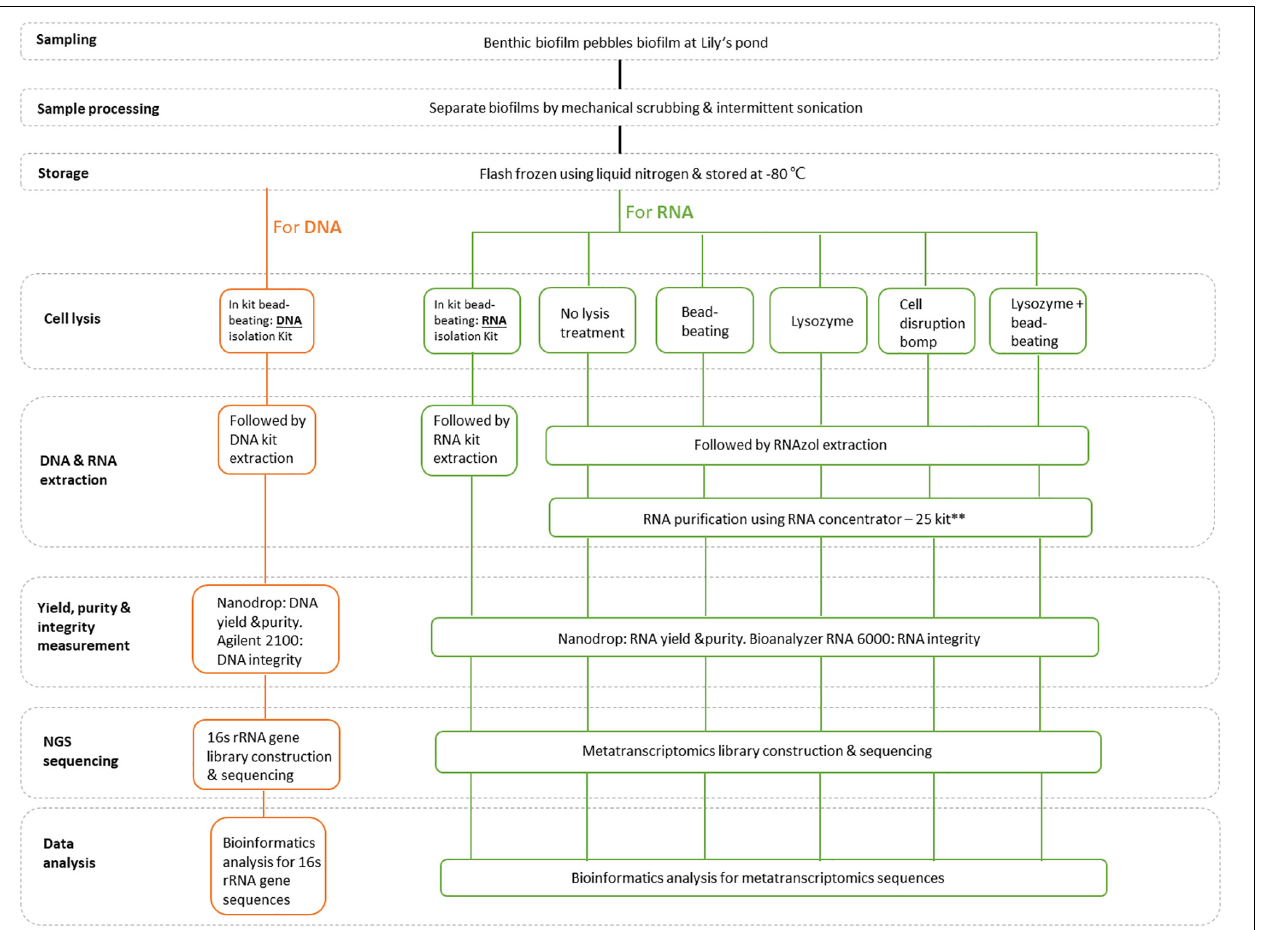
FIGURE 1 | A schematic overview of the study design. **Since the total RNA samples obtained using non-column-based extraction procedures were initially of poor quality, an additional purification step was performed on half of the sample using an RNA Clean & Concentrator-25 kit (Zymo Research, United